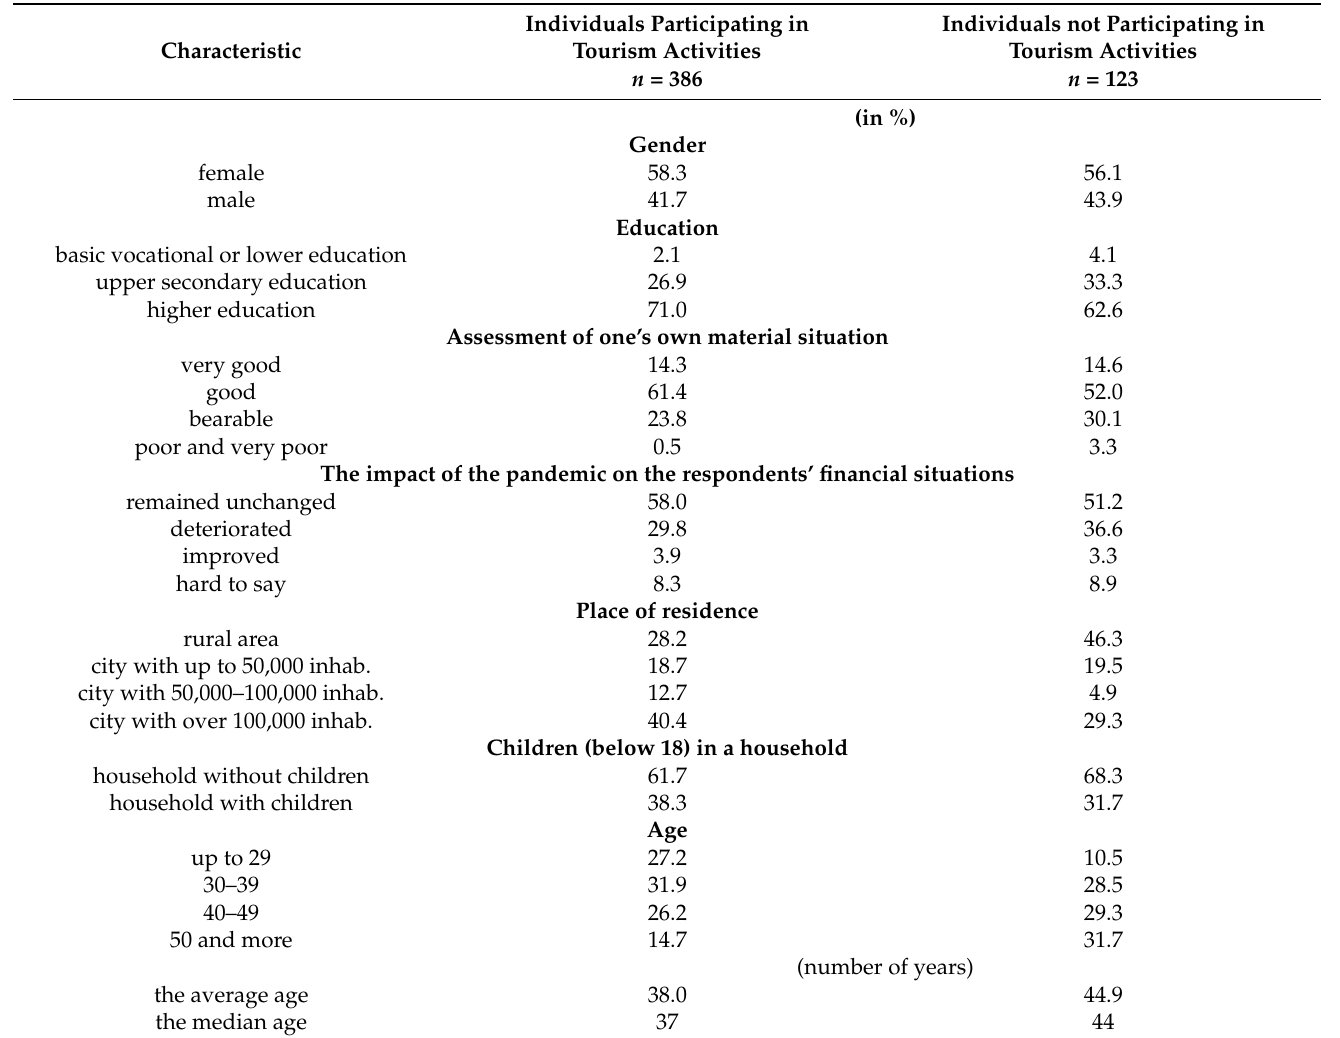
Table 2. Characteristics of the examined group with regard to individuals participating and not participating in tourism activities in 2020 ( n =